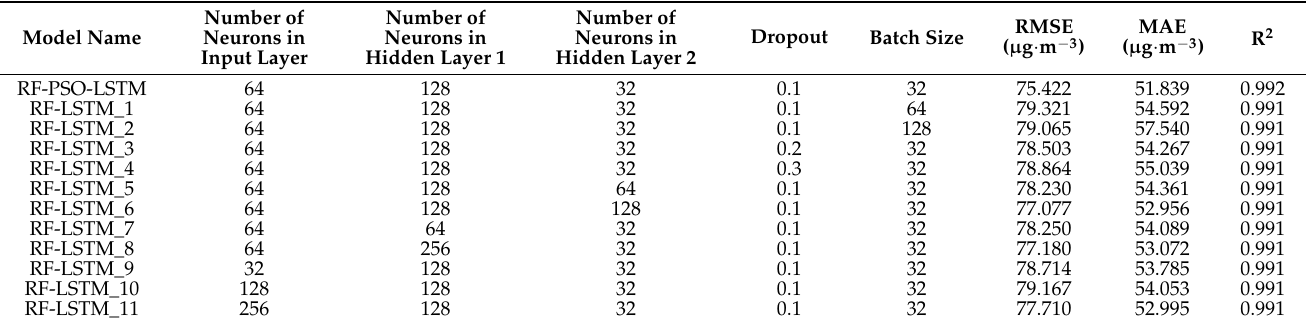
Table 7. Prediction results of LSTM model with different